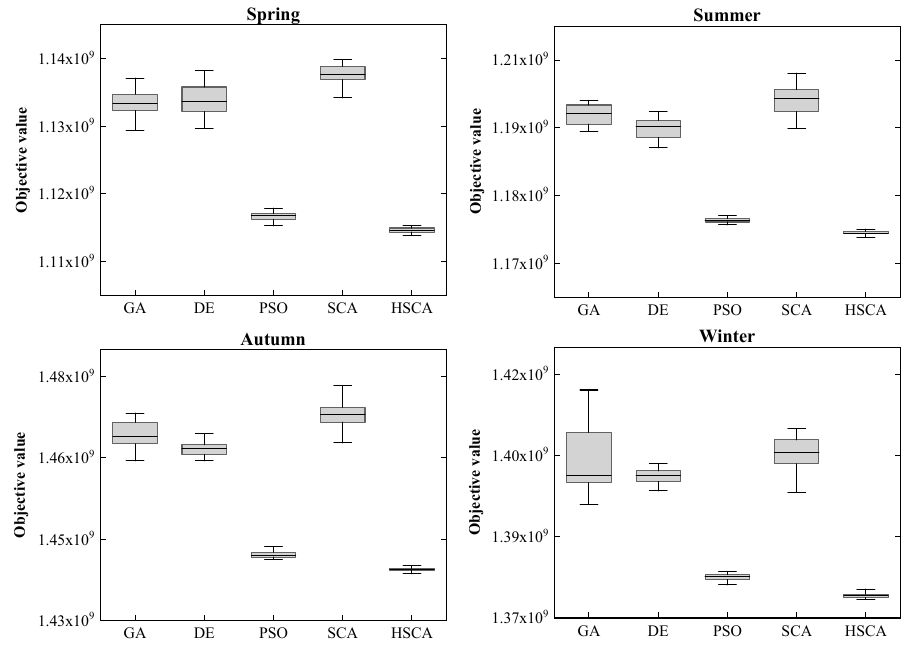
Figure 13. Box plot test for the real-world cascade hydropower system in four seasons.